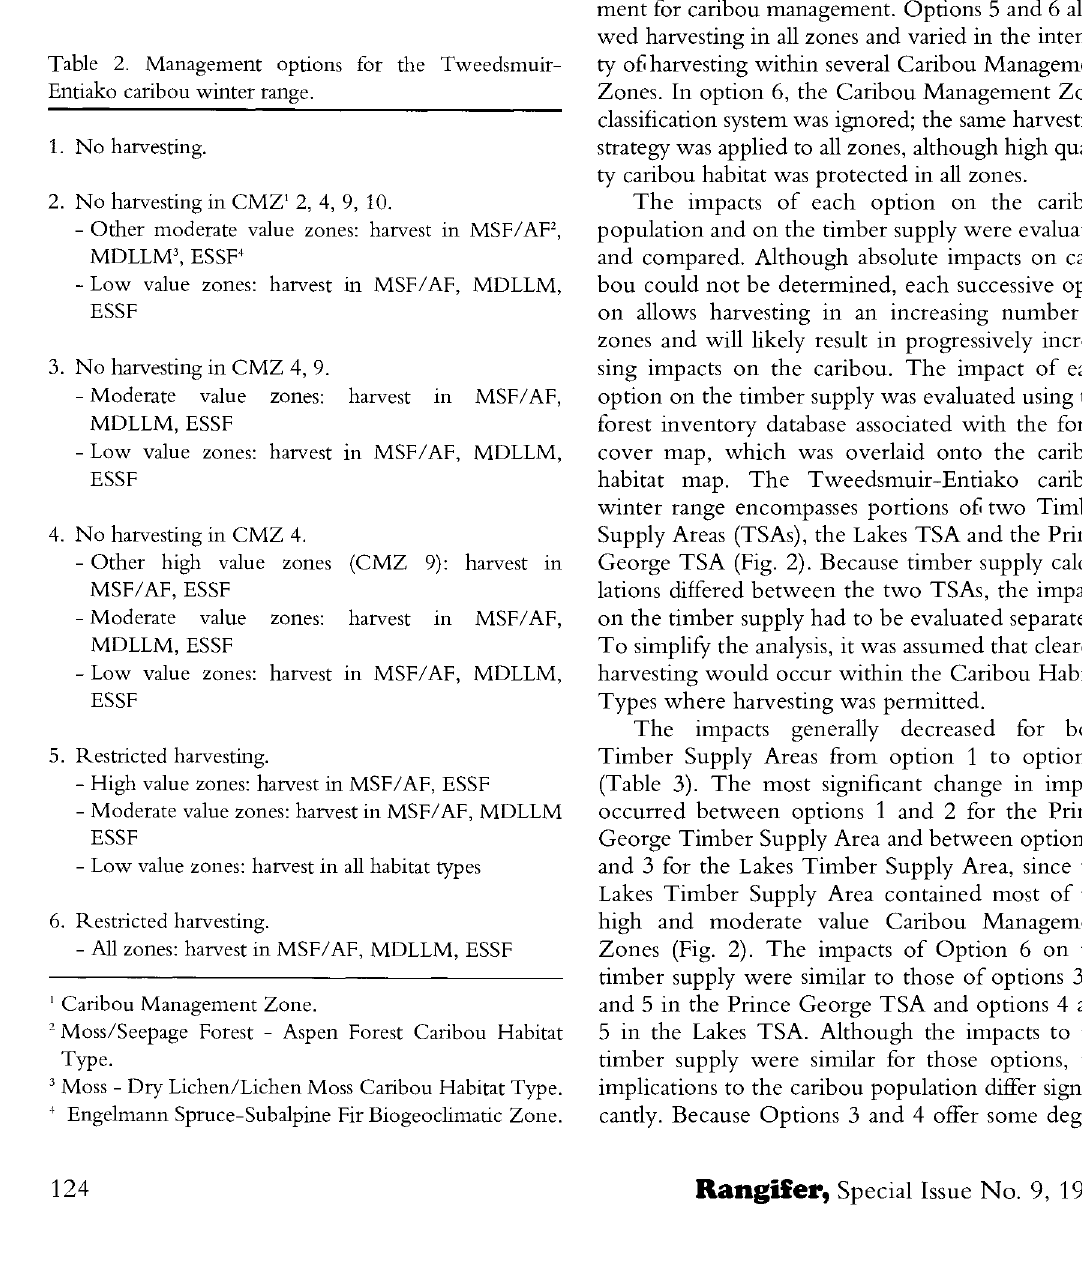
Table 2. Management options for the Tweedsmuir- Entiako caribou winter